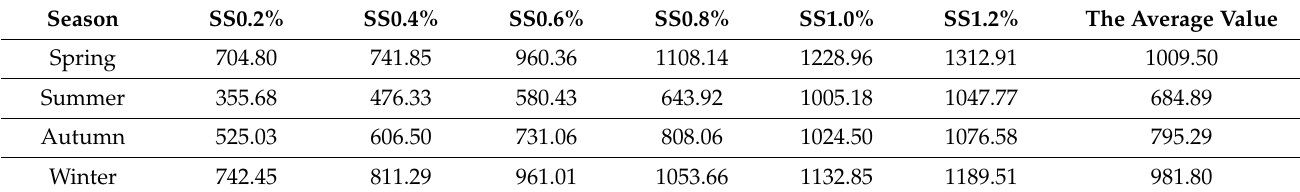
Table 1. The seasonal average value of different levels of supersaturation.